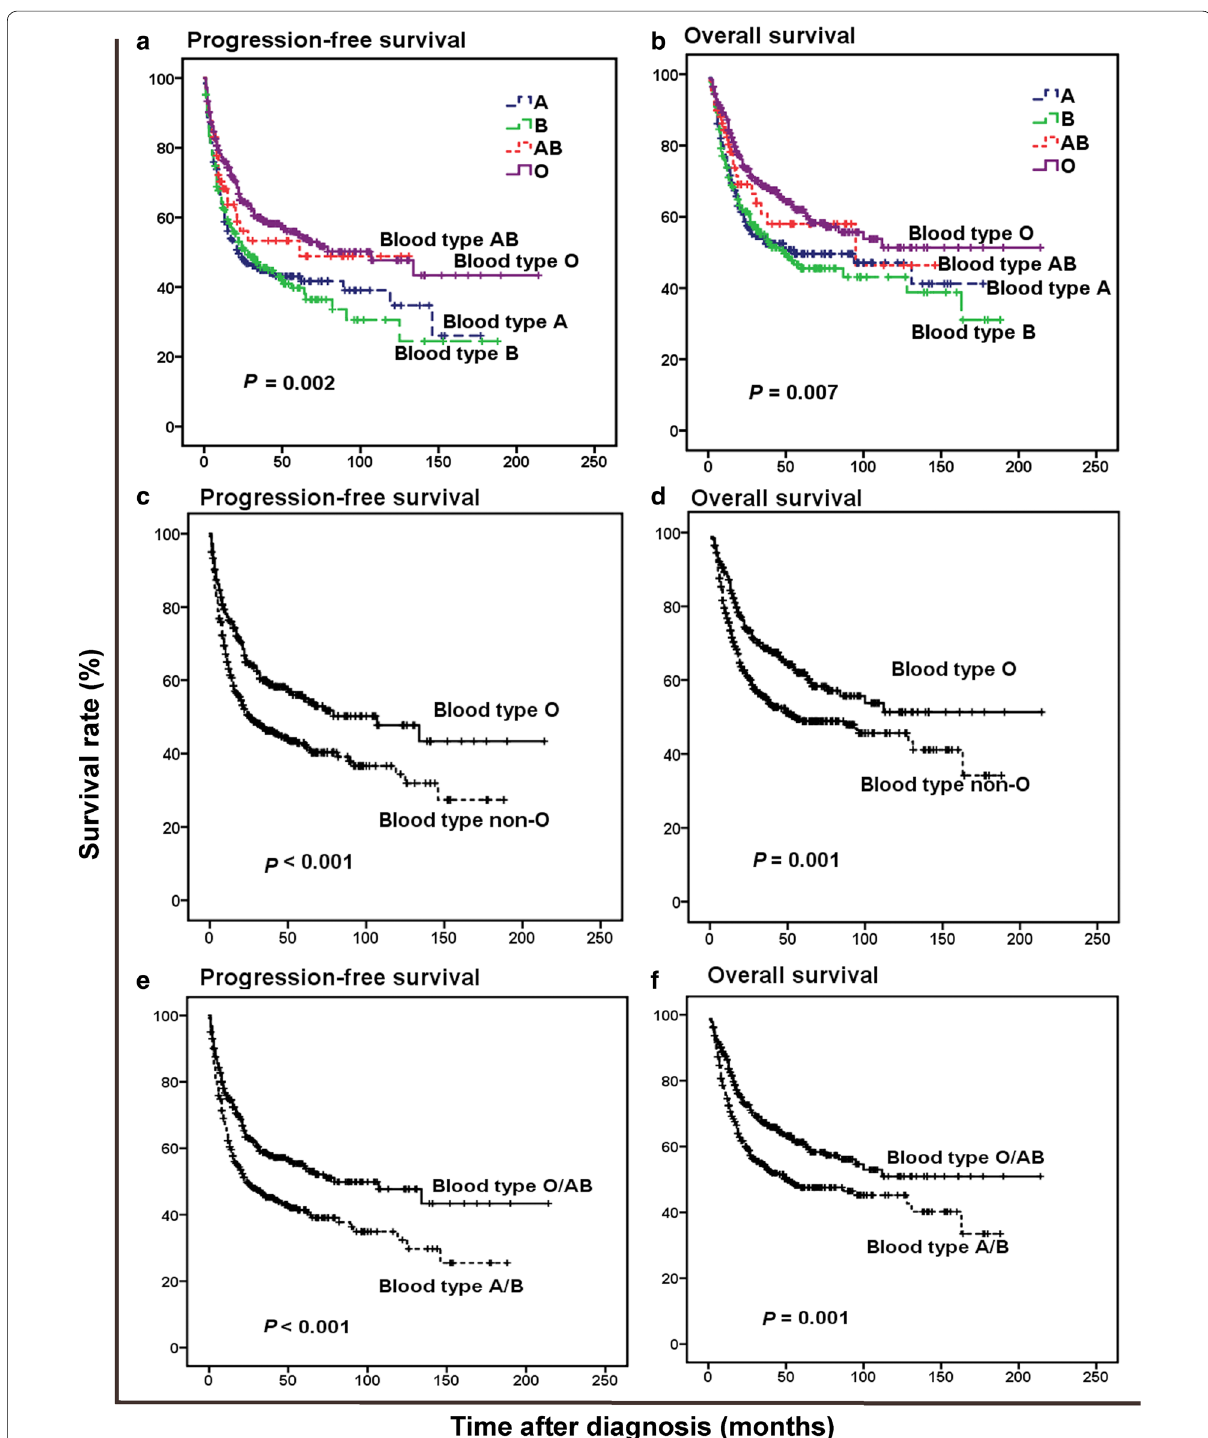
Fig. 1 Survival curves of patients with extranodal natural killer (NK)/T‑cell lymphoma (ENKTL) according to ABO blood type. a Progression‑free survival (PFS) curves of patients according to blood types A, B, AB, and O. b Overall survival (OS) curves of patients according to blood types A, B, AB, and O. c PFS curves of patients according to blood types O and non‑O (A, B, and AB). d OS curves of patients according to blood types O and non‑ O. e PFS curves of patients according to blood types O/AB versus type A/B. f OS curves of patients according to blood types O/AB versus type